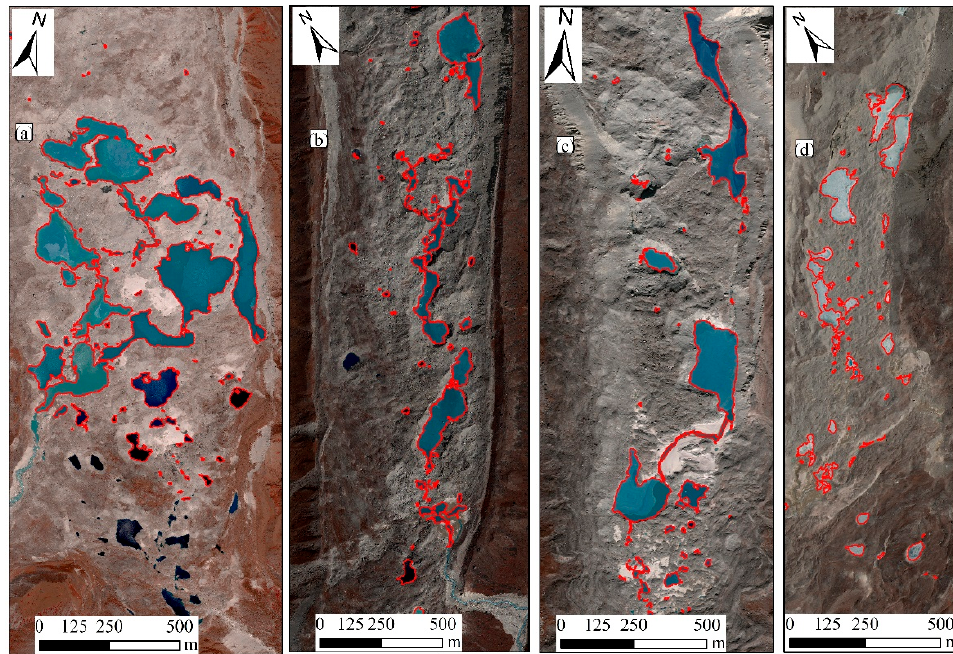
Figure 11. Spillway ponds and associated supraglacial ponds at the termini of ( a ) Ngozompa Glacier from November 2016, ( b ) Khumbu Glacier from October 2016, ( c ) Bhote Koshi Glacier from November 2015, and ( d ) Lumsamba Glacier from April 2016.